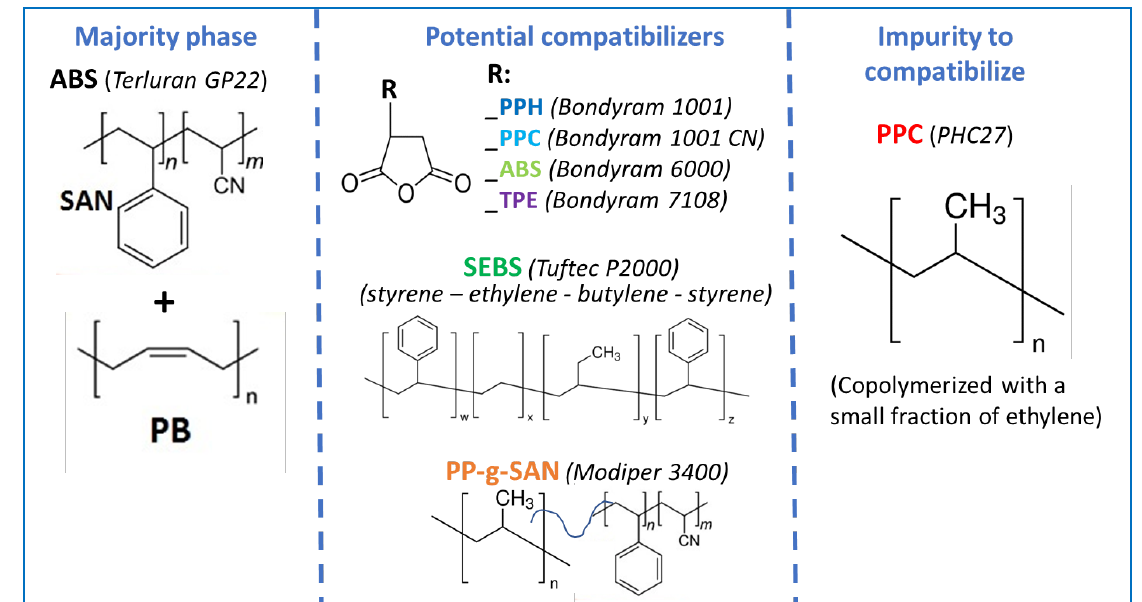
Figure 1. Materials